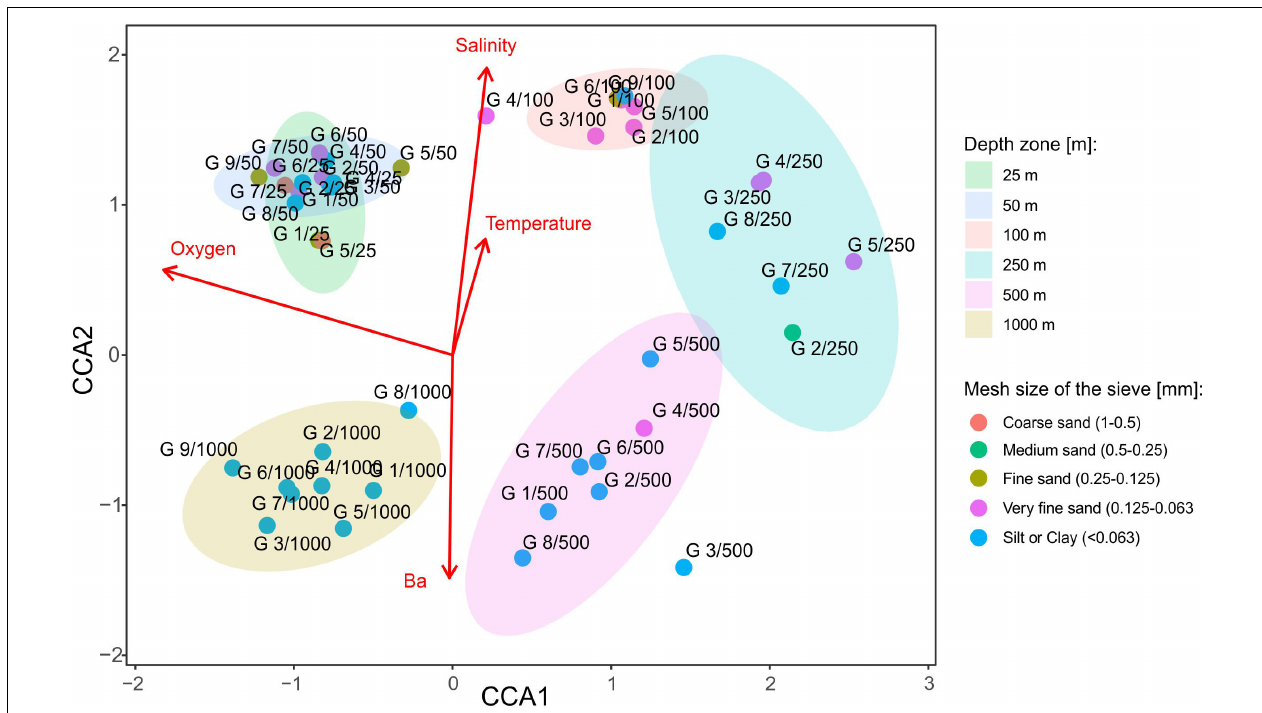
FIGURE 9 | Canonical correspondence analysis (CCA) showing species composition differences on each sampling site with selected environmental factors as red arrows (barium, temperature, salinity, and oxygen). Sediment size is differentiated by the color of the points. In addition, to describe species composition along the depth gradient, depth zones were distinguished as ellipses with 0.95 confidence intervals. Only statistically significant variables were included into ordination analysis. See Supplementary Appendix 1 for a full list of factors.